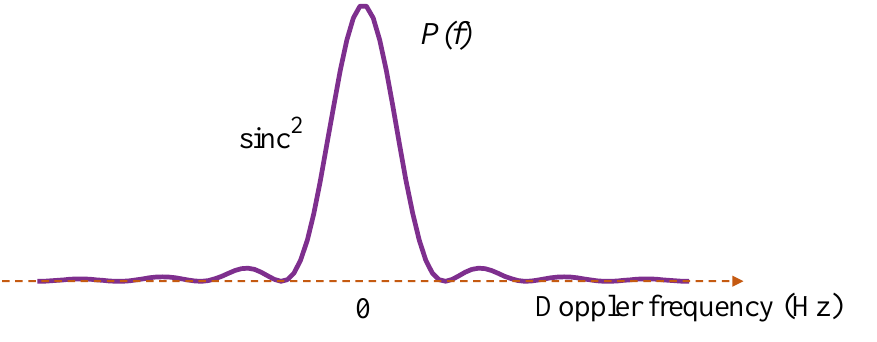
Figure 3. The two-way antenna pattern P ( f )